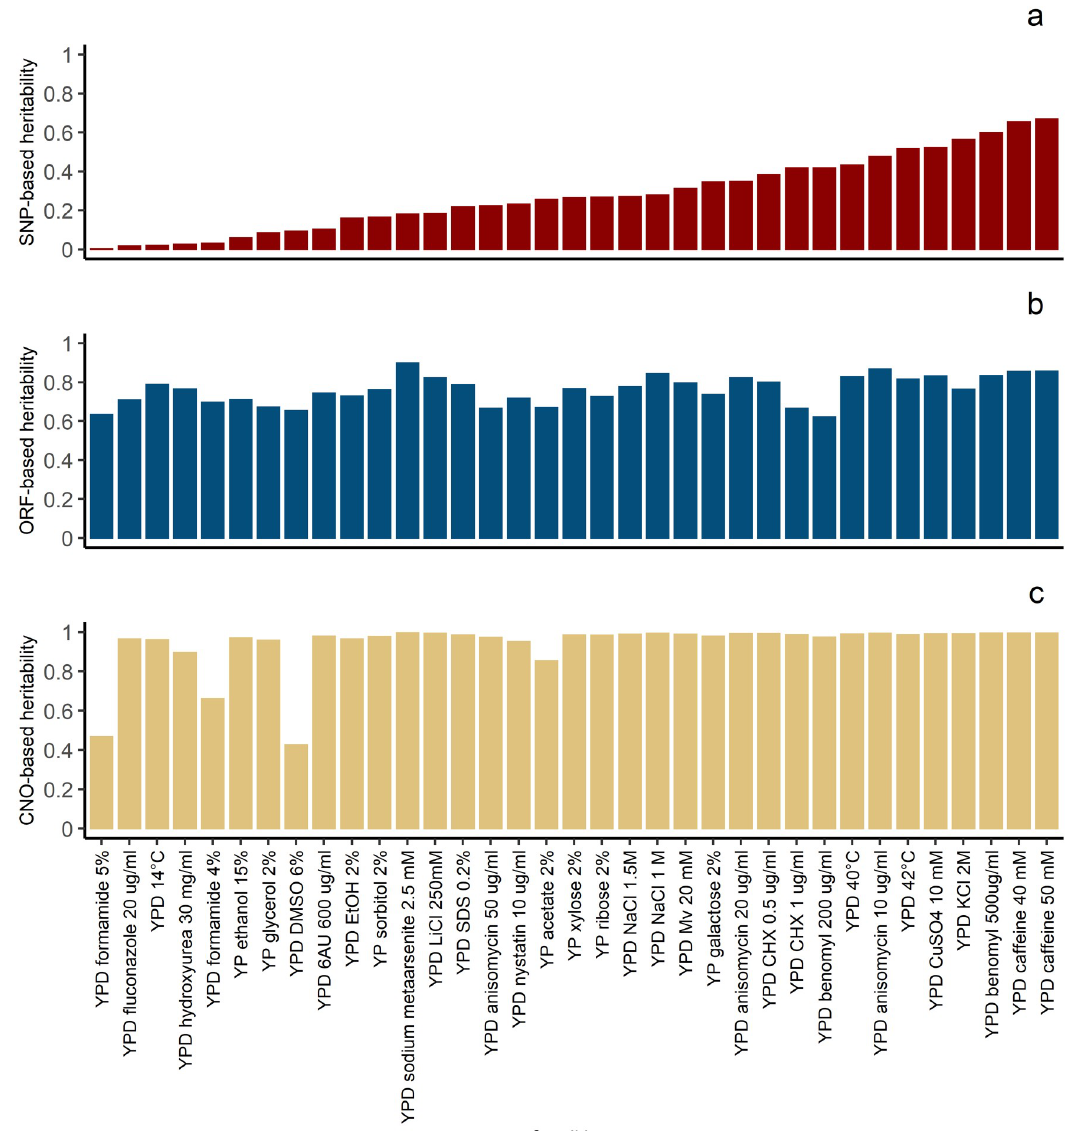
Fig 2. Heritability estimates for all 35 traits estimated based on three data types. Panel a , b , and c depict heritability estimates for all 35 traits estimated based on SNPs with MAF � 0.01, pan-genomic open reading frames with frequency � 0.05, and the copy numbers of pan-genomic open reading frames with frequency � 0.05, respectively. All standard errors were below